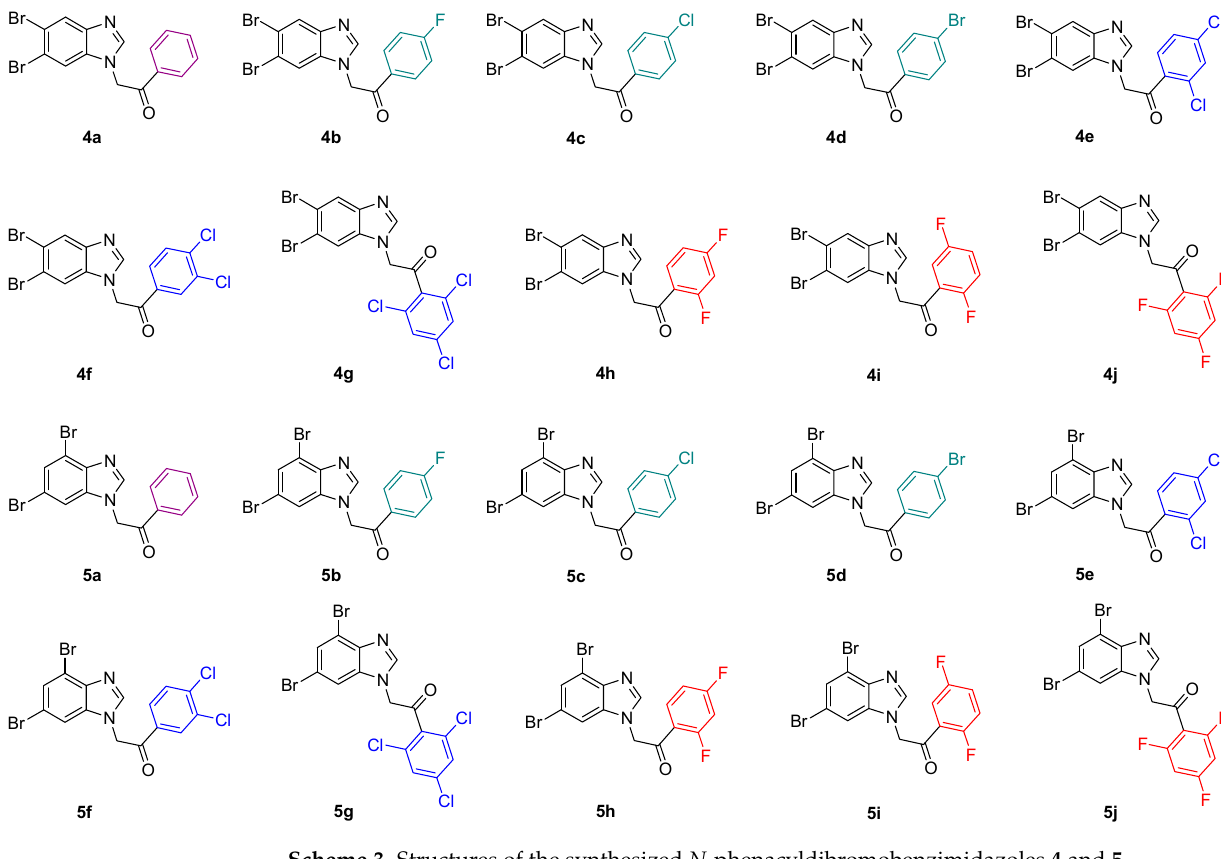
Figure 1. The ORTEP view of the molecule of 1-(4-bromophenyl)-2-(4,6-dibromo-1 H -benzimidazol- 1-yl)ethanone ( 5d ). The non-hydrogen atoms are shown as 30% probability ellipsoids (CCDC2171992). To explain the low synthesis yields of compounds 4 and 5 in the K 2 CO 3 –MeCN sys- tem, we carried out the reaction of the model substrate, 2,4-dichlorophenacyl chloride 3e ,